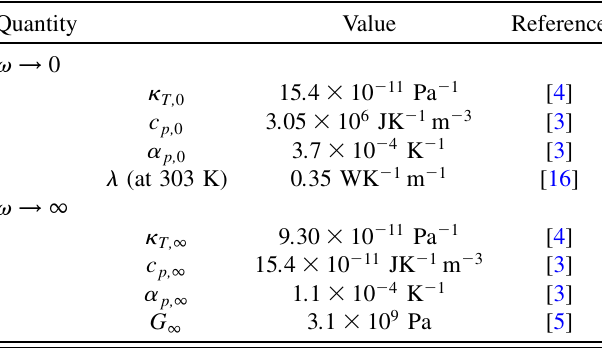
TABLE I. Literature data for glucose (at 300 K) used to parametrize the model depicted in the electrical equivalent diagram in Fig. 7. We have used a density of 1 : 52 (cid:4) 10 3 kg m (cid:2) 3 to convert specific-heat data from mass to volume.